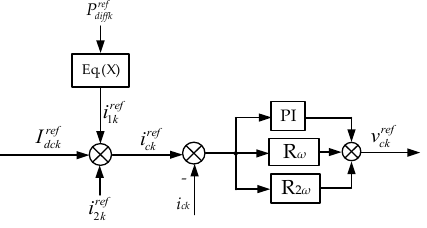
Figure 7. Circulating current control diagram.